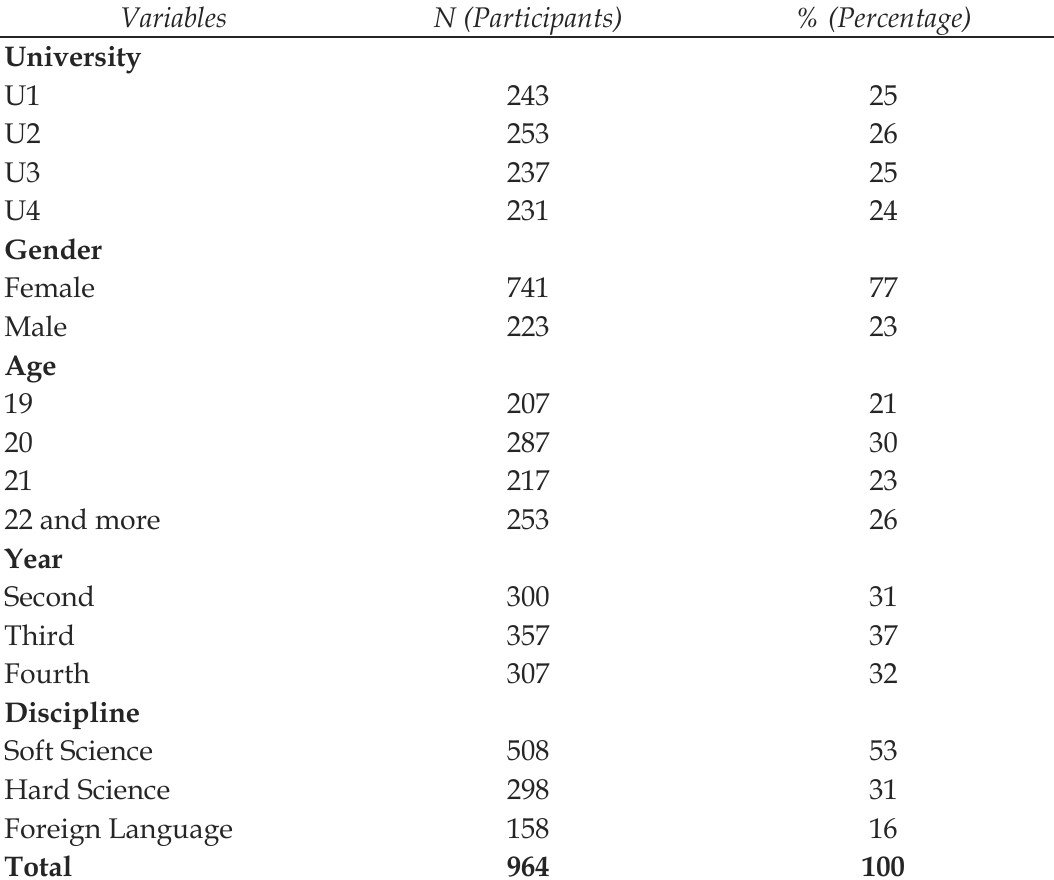
Table 1. Distribution of students by independent